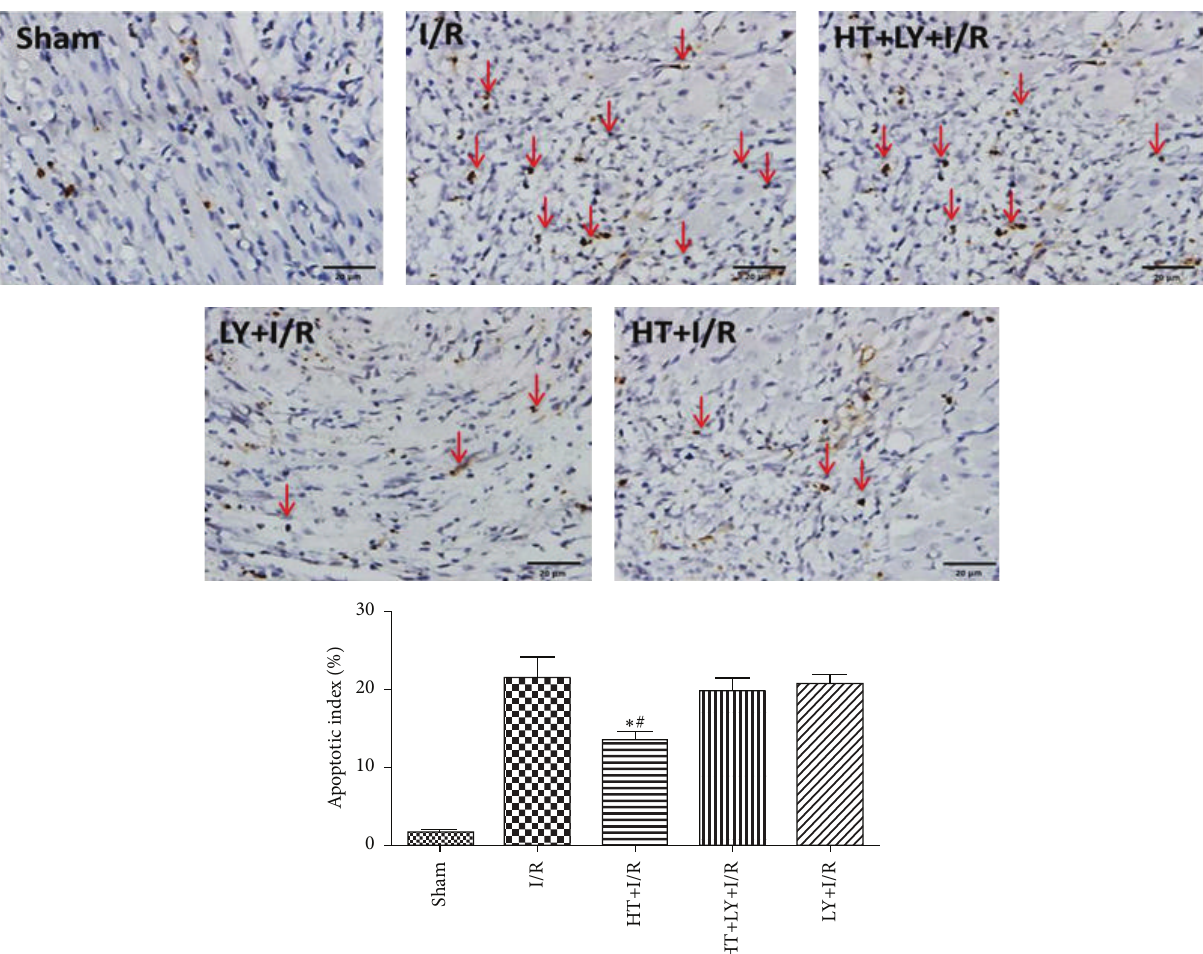
Figure 4: HT treatment attenuates cardiomyocyte apoptosis following myocardial I/R ( 𝑛 = 4 for each group). Hearts were harvested and sectioned for analysis of apoptosis by the TUNEL assay. Blue staining indicates the nucleus of each cell, and the dark brown staining indicates apoptotic cardiomyocytes, which are marked by red arrows. The bar graph shows the percentage of apoptotic cells. ∗ 𝑃 < 0.05 versus I/R group. # 𝑃 < 0.05 versus HT+LY+I/R